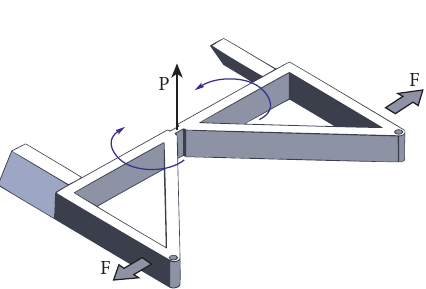
Figure 6: Reinforced section, the force is applied to the corners.